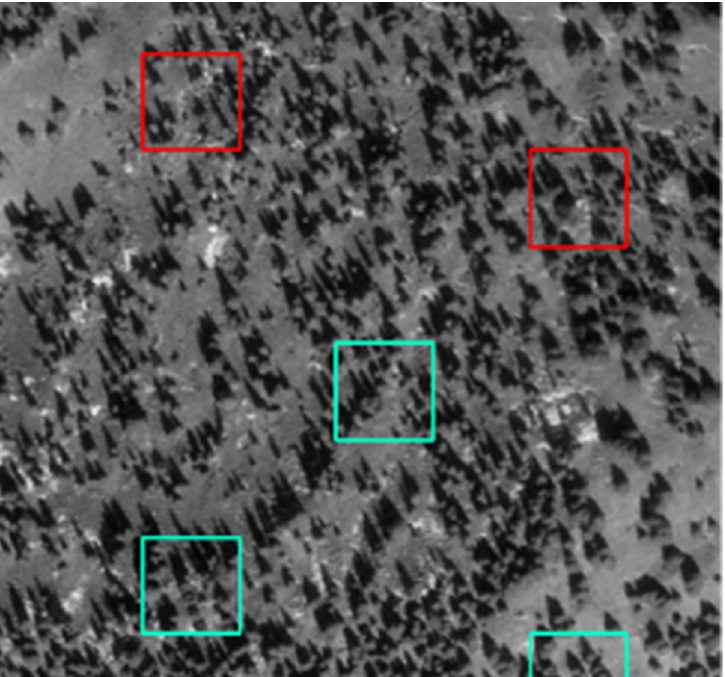
Figure 16. Disagreement of the class “dense forest” obtained by CNNs and visual image interpretation due to an unclear boundary of the semantic concept definition. Blue-green image patches correspond to agreement for the class “dense forest” and red image patches correspond to disagreement.